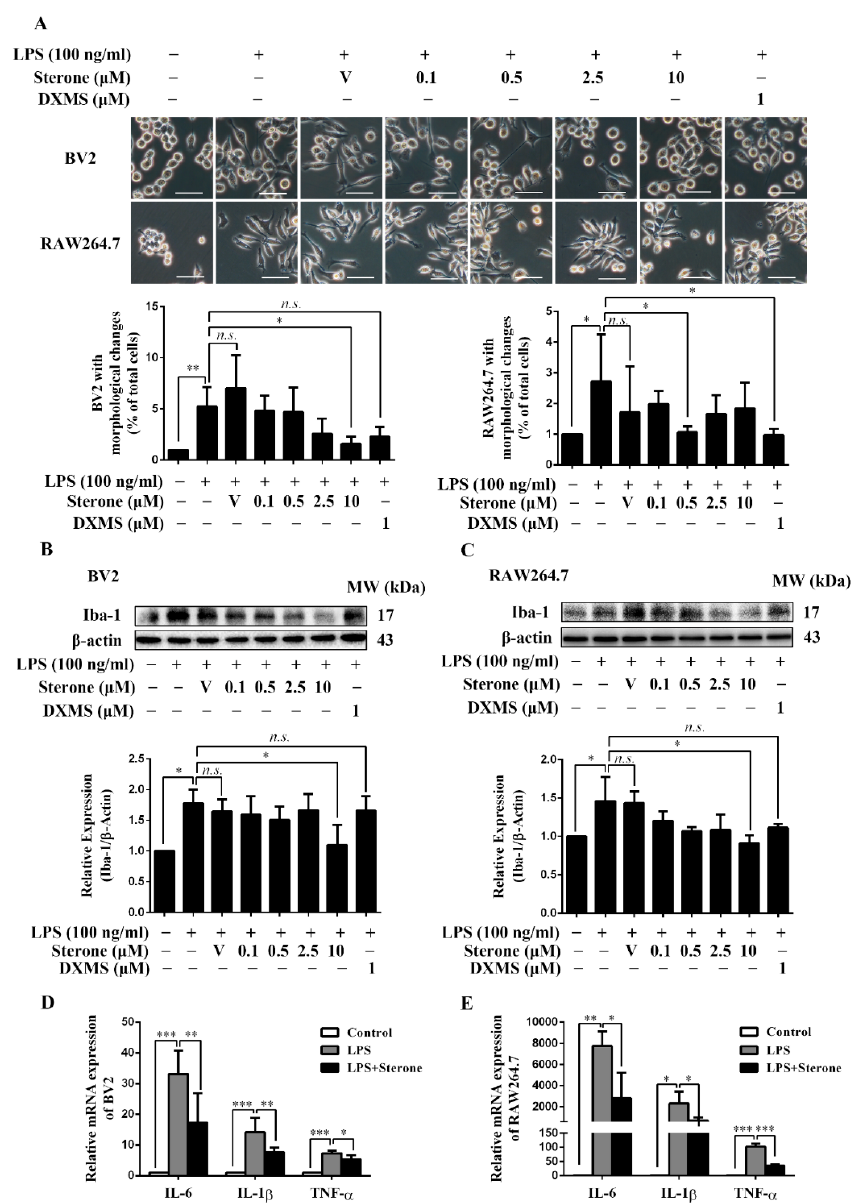
Figure 2. Sterone inhibited the LPS-induced inflammatory activation of BV2 and RAW264.7 cells. Cells were pre-treated with the indicated concentrations of sterone or the positive control of dexamethasone (DXMS) for 30 min before the stimulation with 100 ng/mL LPS for 6 h individually. The cellular morphological changes are presented in microphotographs and statistical graphs ( A ). Protein levels of the biomarker Iba-1 were measured using western blotting. Representative images of BV2 ( B ) and RAW264.7 cells ( C ) from more than three independent experiments are shown. The mRNA levels of IL-6, IL-1 β , and TNF- α were measured using RT-qPCR respectively in BV2 ( D ) and RAW264.7 cells ( E ). V, Vehicle (HP- β -CD). Scale bars, 50 μ m. Values are mean ± SD of three independent experiments. n.s, no significance. * p < 0.05, ** p < 0.01, *** p < 0.001.